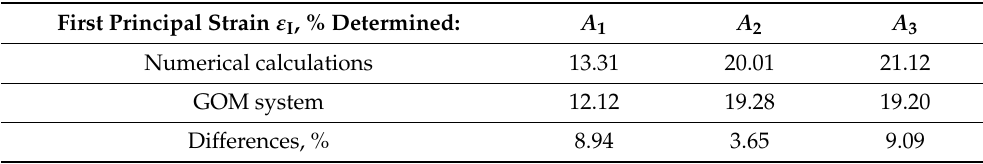
Figure 8. Distributions of the first principal strain determined using GOM software accompanying the experimental tests, view from GOM Correlate software for the sample: ( a ) A 1 , ( b ) A 2 , ( c ) A 3 . Table 5. Comparison of the values of the first principal strains determined numerically and those obtained by using the GOM